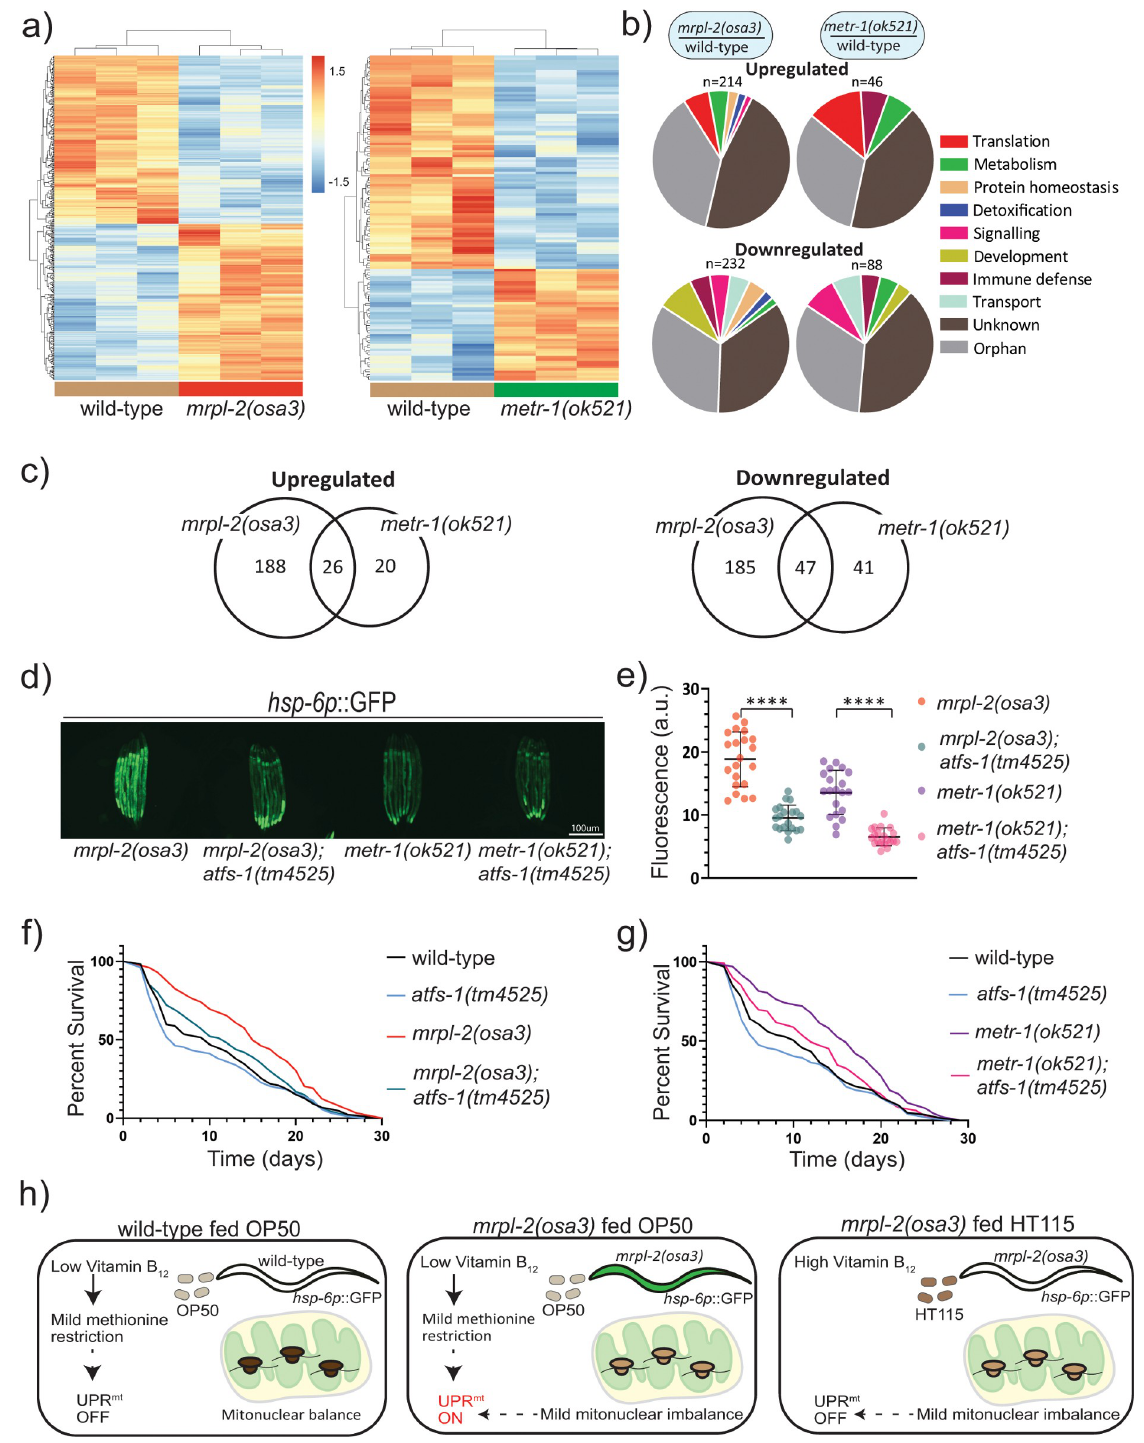
Fig 7. ATFS-1/UPR mt mediate the lifespan extension of mitonuclear imbalance and methionine restriction. (A) Heat maps representing gene expression changes in wild-type, mrpl-2(osa3) , and metr-1(ok521) fed an E . coli OP50 diet. Genes were considered as differentially expressed if there was a significance difference of p � 0.05 (after Benjamini-Hochberg correction). (B) Functional categories of differentially expressed genes. (C) Venn diagram of differentially expressed genes shared between mrpl-2(osa3) and metr-1(ok521) . (D, E) Photomicrographs and quantification of hsp-6p ::GFP expression for mrpl-2(osa3) , mrpl-2(osa3) ; atfs-1(tm4525) , metr-1(ok521) , and metr-1 (ok521); atfs-1(tm4525) fed a diet of E . coli OP50. Quantification of fluorescence intensities expressed as arbitrary units (A.U.); (mean ± SD;